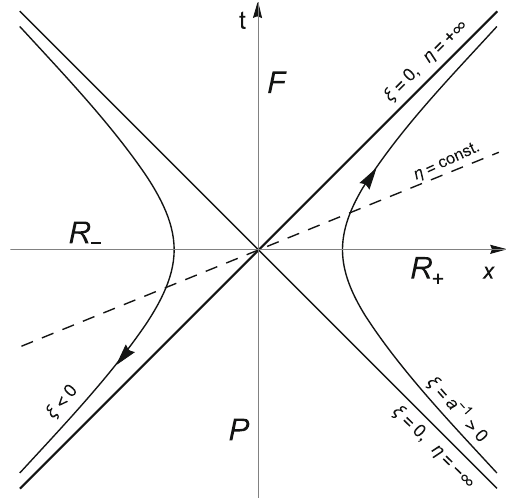
Fig. 1 Rindler chart of a uniformly accelerated (Rindler) observer in Minkowski spacetime